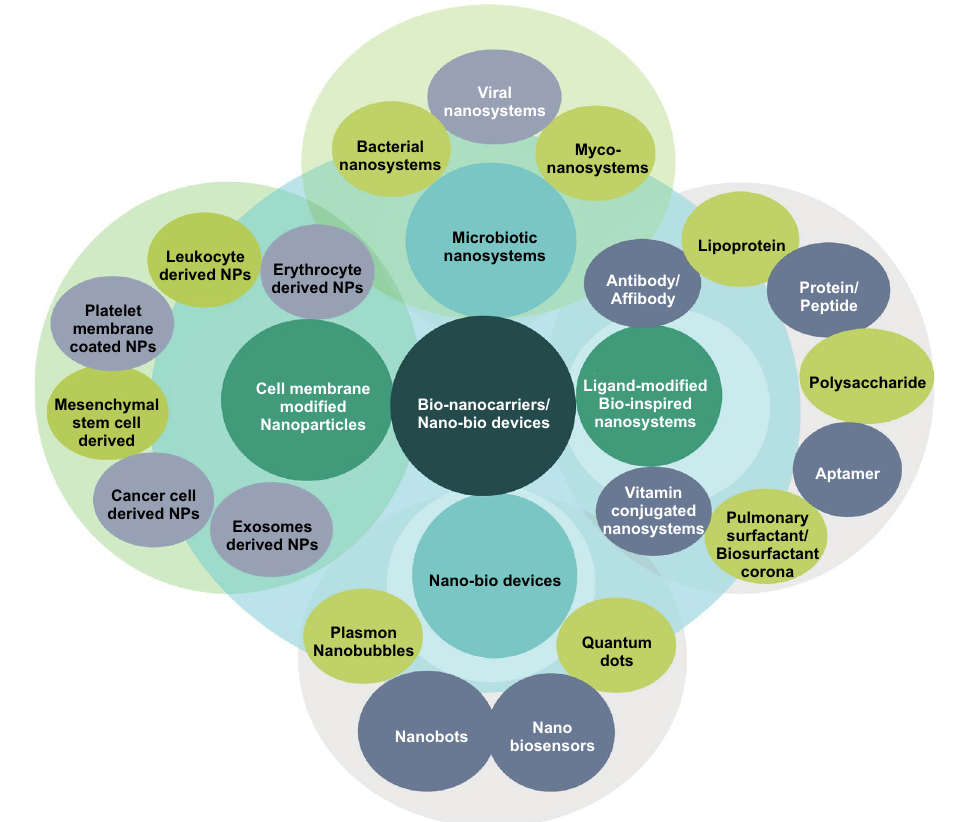
Fig. 1 Bio-nanocarriers and nano-bio-devices for oncological